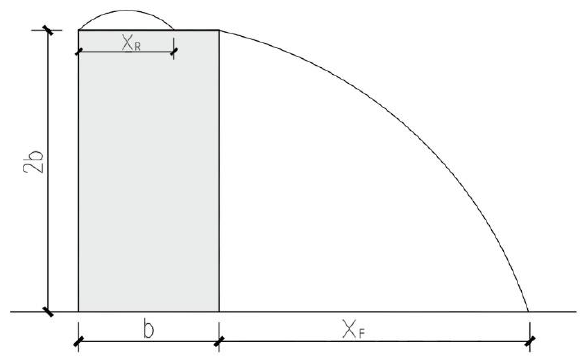
Figure 7. Section of mesh scheme for Case 2.